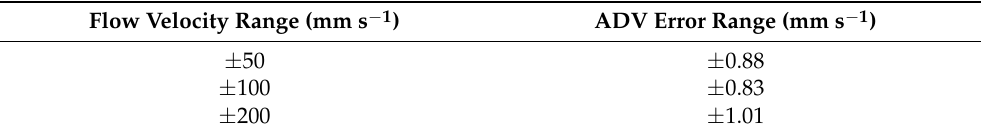
Table 1. Values of errors ADV measurements (in mm s − 1 ).